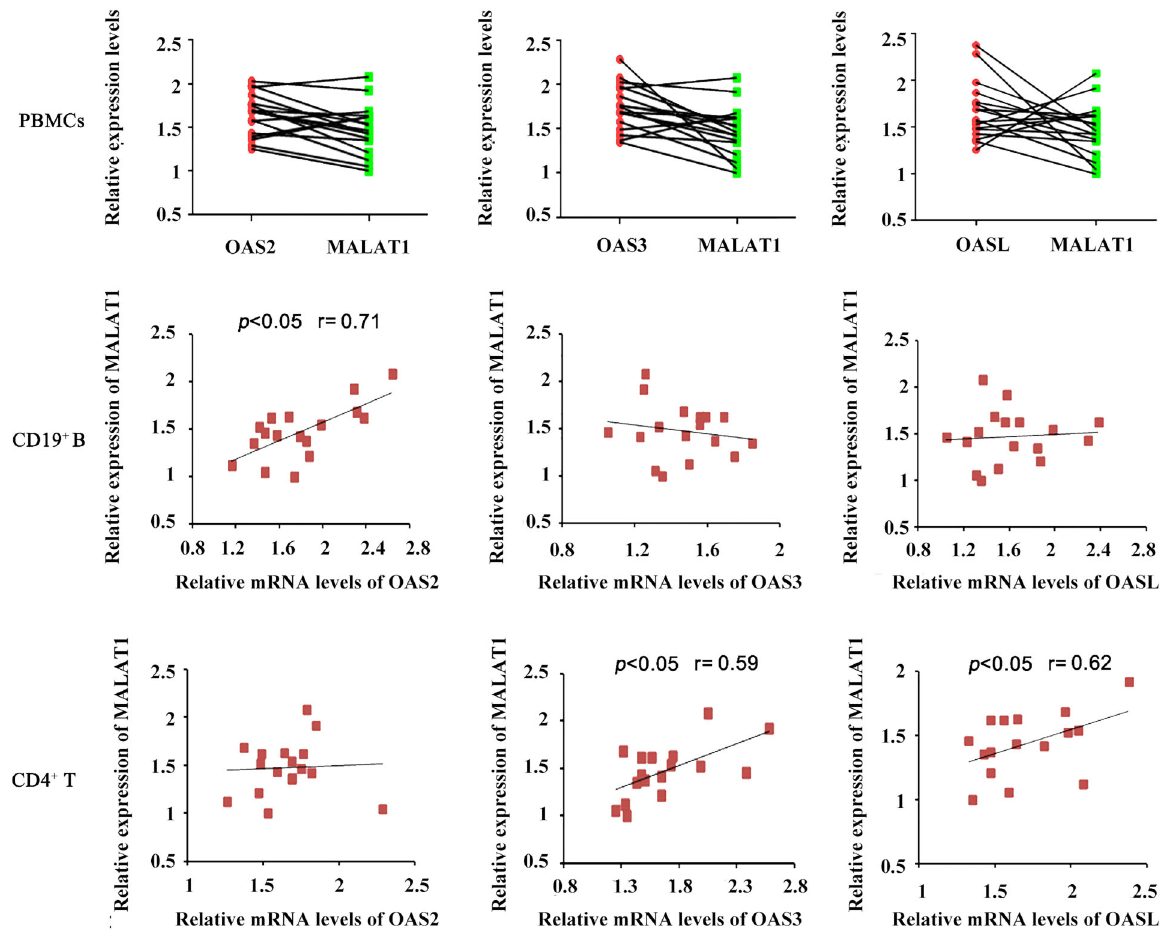
Figure 4. Positive correlation of MALAT1 expression with OAS2, OAS3, and OASL expression in immune cells. Pearson ’ s correlation analysis was used to determine the correlation of MALAT1 expression with OAS2, OAS3, and OASL expression in peripheral blood mononuclear cells (PBMCs), CD19 + B cells, and CD4 + T cells from systemic lupus erythematosus